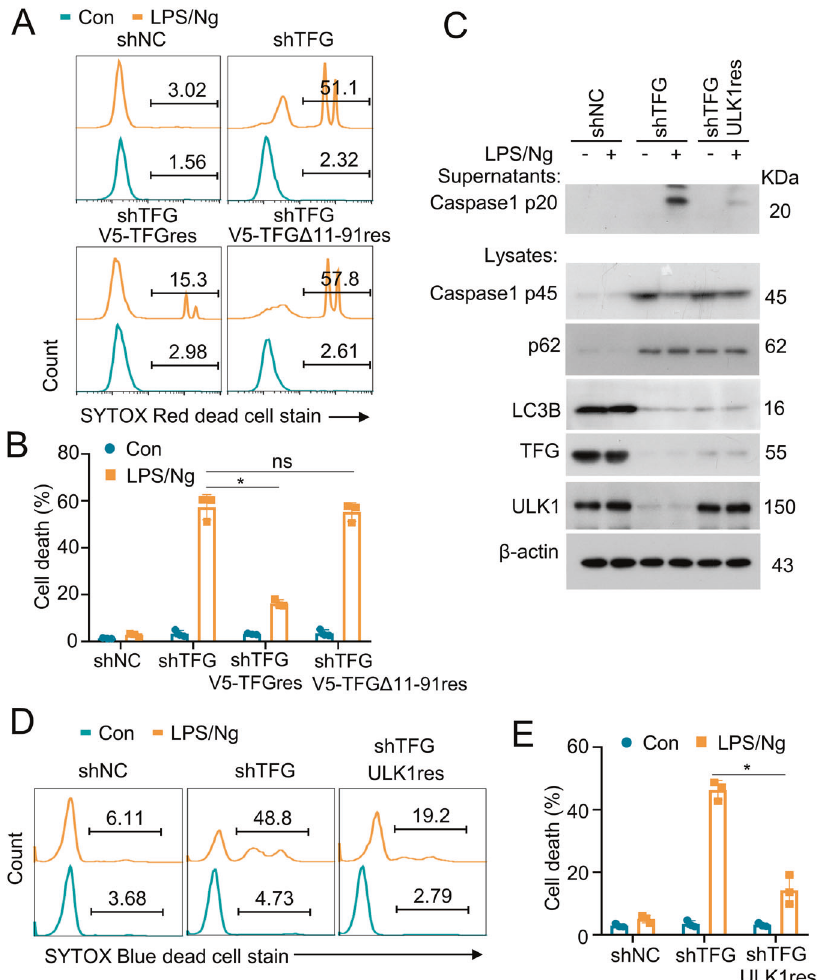
Fig. 7 Rescue of ULK1 expression blocks LPS/Ng-induced cell death in TFG-de fi cient THP-1 cells. A THP-1 cells were transduced with shNC or shTFG. TFG stable knockdown THP-1 cells were then transfected with V5-TFG rescue or V5-TFG Δ 11 – 91 rescue expression vectors to